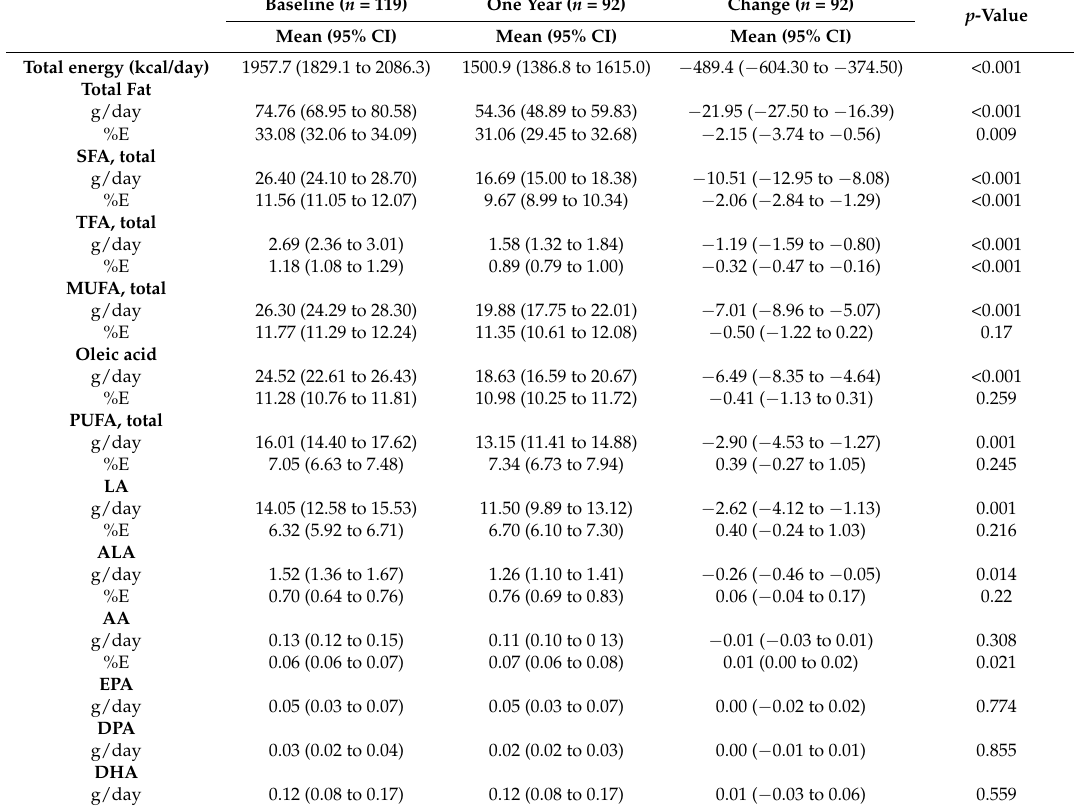
Table 3. Comparison of intakes of selected fatty acids between baseline and one